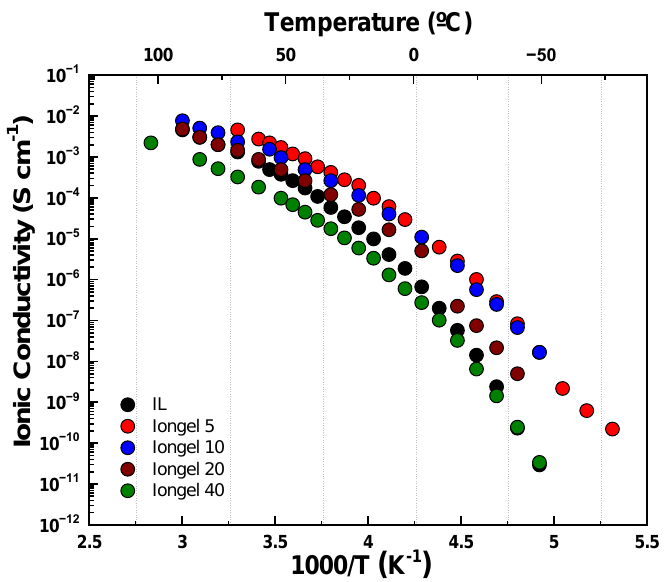
Figure 3. Ionic conductivity as a function of temperature for IL and iongels.